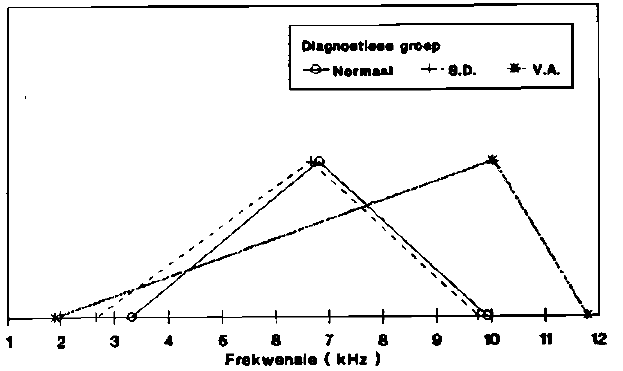
Figuur 5. Gemiddelde minimum en maksimum frekwensie-waardes en piek van gekonsentreerde energie vir die [s] van die verskillende diag- nostiese